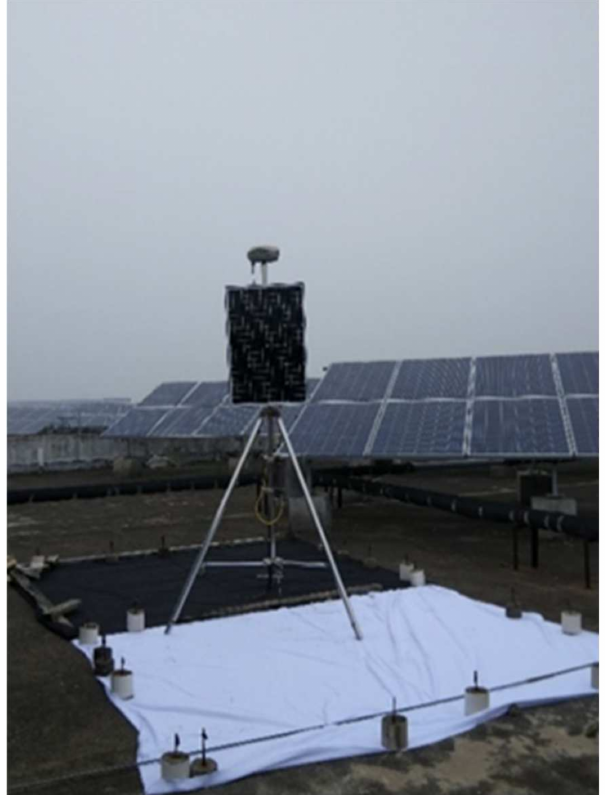
Figure 13. Equipment site installation